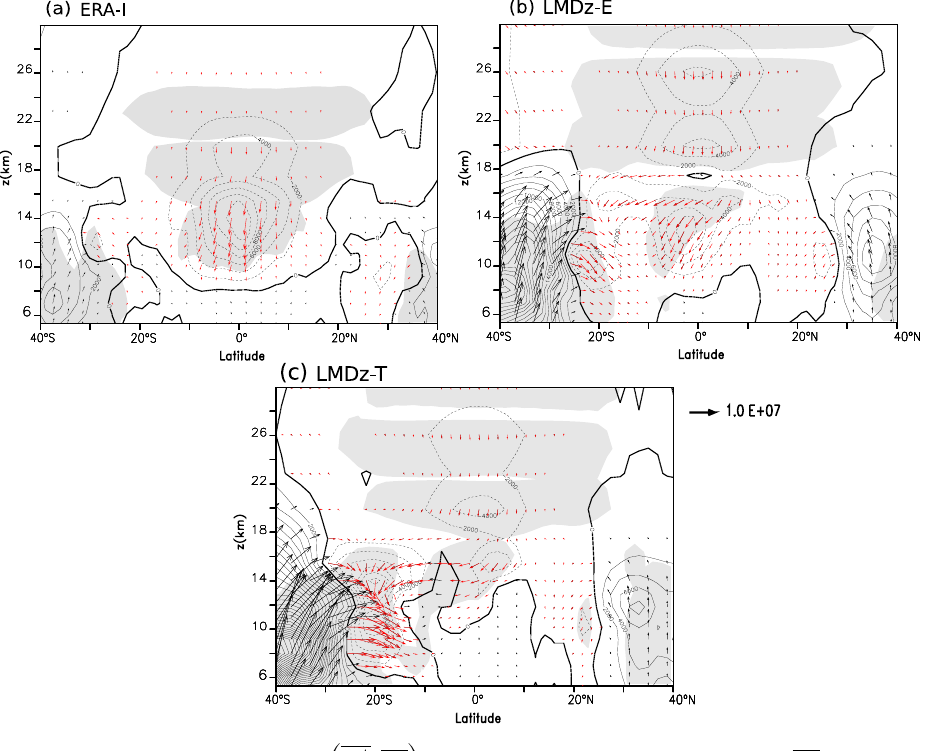
(cid:16) (cid:17) F φ ,F z Fig. 10. Composite of the Eliassen–Palm flux vector (arrows) and of its vertical component F z (contours with negative val- ues dashed, interval of 1000 Pa, red (black) arrows corresponding to negative (positive) vertical component F z ): (a) ERAI, (b) LMDz-E, (c) LMDz-T. The grey shaded areas corresponding to the 99% significant regions of the vertical component of the EP flux according to a Student t test evaluated for the horizontal and vertical